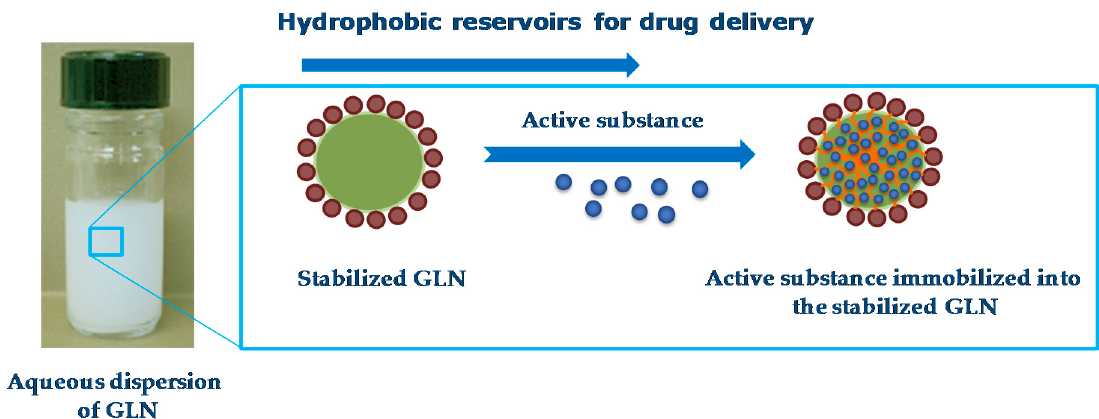
Figure 12. Representation of the drug delivery ability of GLN.